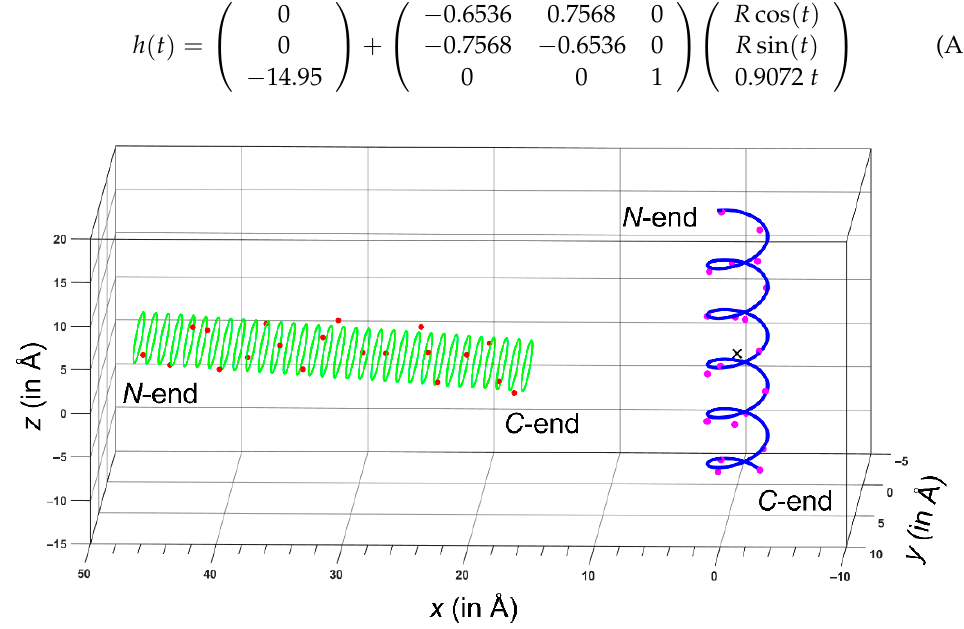
Figure A1. The cylinder fitted to original C α positions, and the parametrized helix, together with projected positions of carbonyl carbons of the ALM backbone.